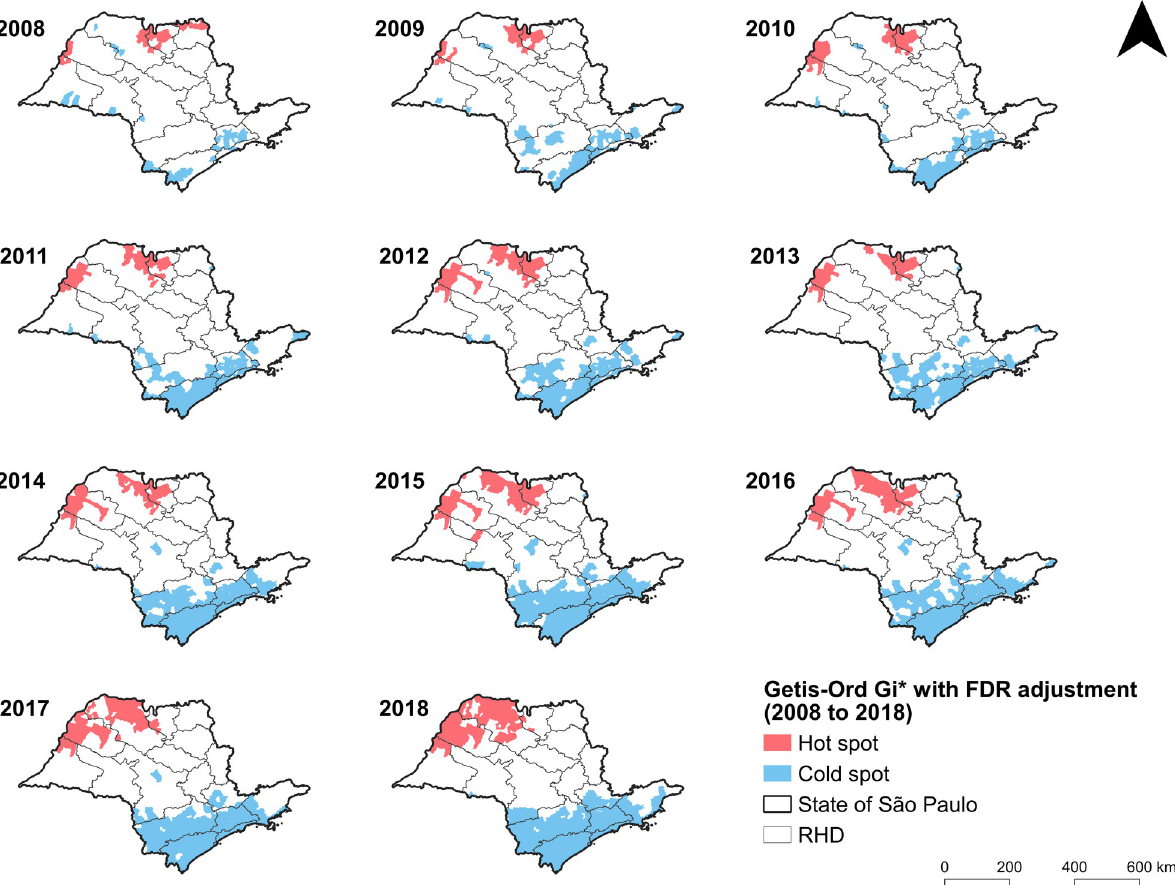
Fig 5. Spatial clusters of the Getis-Ord Gi � statistic with false discovery rate (FDR) adjustment for municipalities in the state of S ã o Paulo, Brazil from 2008–2018.